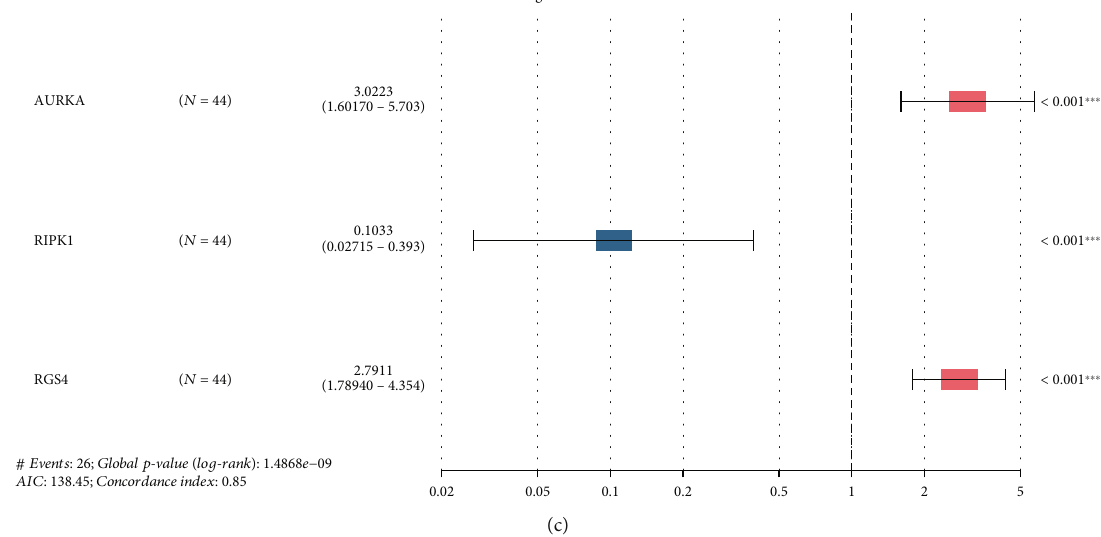
Figure 2: Key FRG selection and gene signature construction process. (a) Estimation of the random forest OOB prediction error rate based on the number of trees. (b) 13 genes ranked in both top 15 VIMP and minimal depth. (c) The forest map composed of 3 independent prognostic characteristic